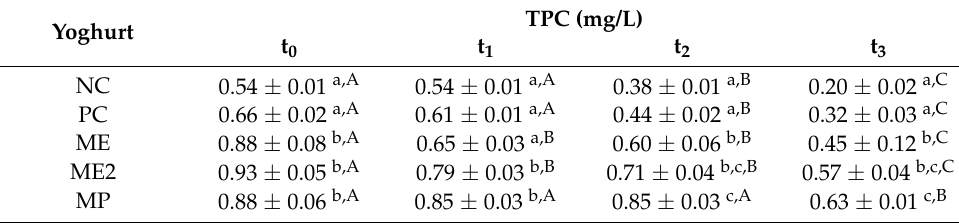
Table 5. Total phenolic content variation of the yoghurts throughout the period of the study.